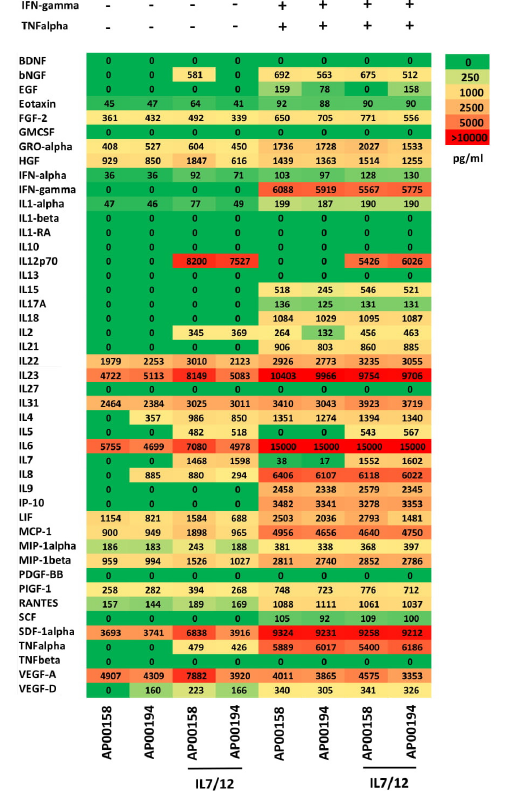
Figure 2. Non-modified MSCs and IL7 / IL12 engineered MSCs have a similar pattern of secreted cytokines that is altered in presence of TNF- α and IFN- γ . MSCs of two donors were transduced to secrete IL7 and IL12, respectively, and cultivated for 72 h (25,000 / mL) in presence and absence of added TNF- α (10 ng / mL) and IFN- γ (10 ng / mL), respectively. Supernatants were collected and subjected in duplicates to 43-parameter multiplex analysis as described in Materials and